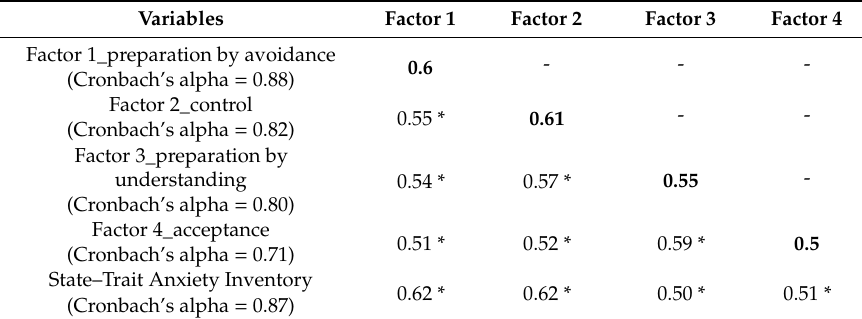
The oblique bolded section: discriminant validity, The non-bolded section: correlation, * p <